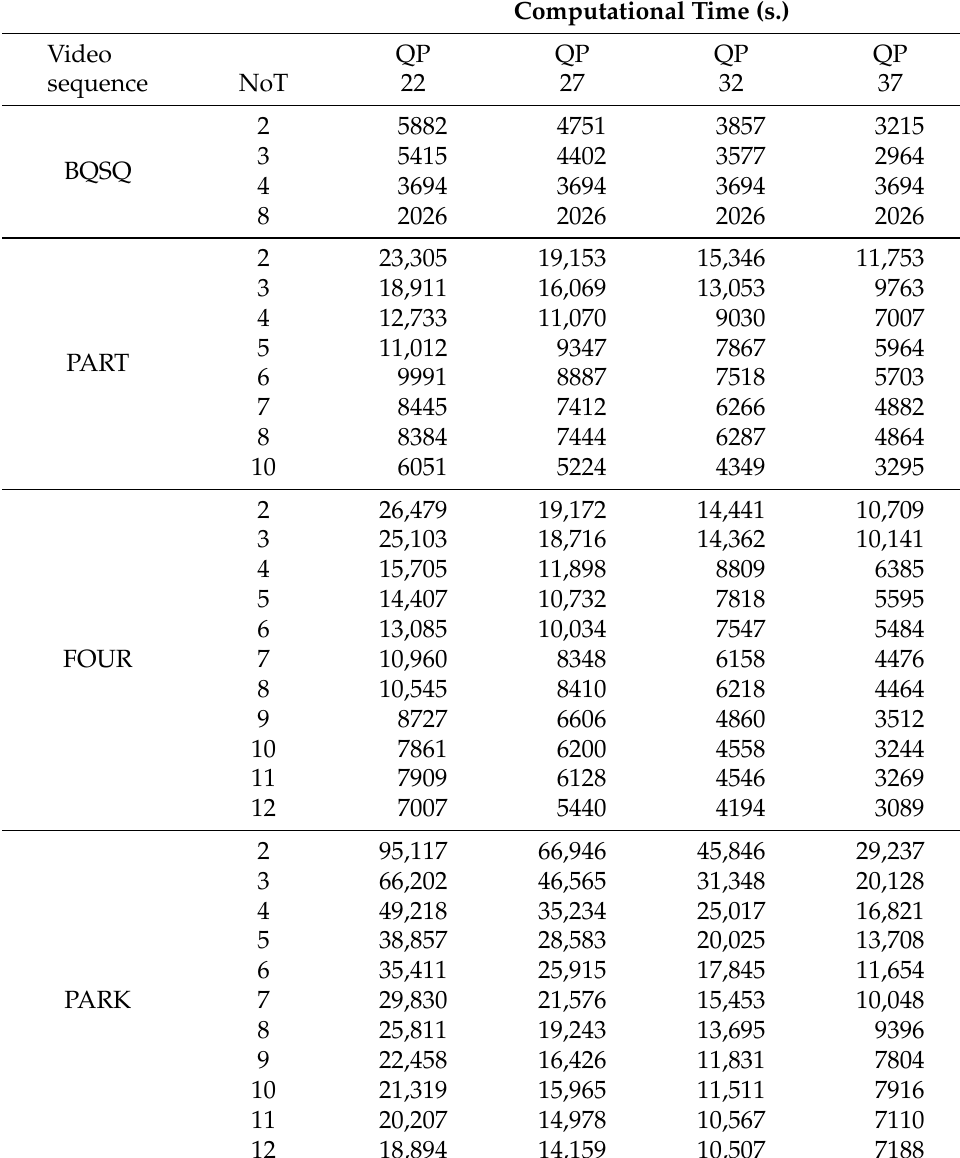
Table 13. Computational times (s.) for Algorithm